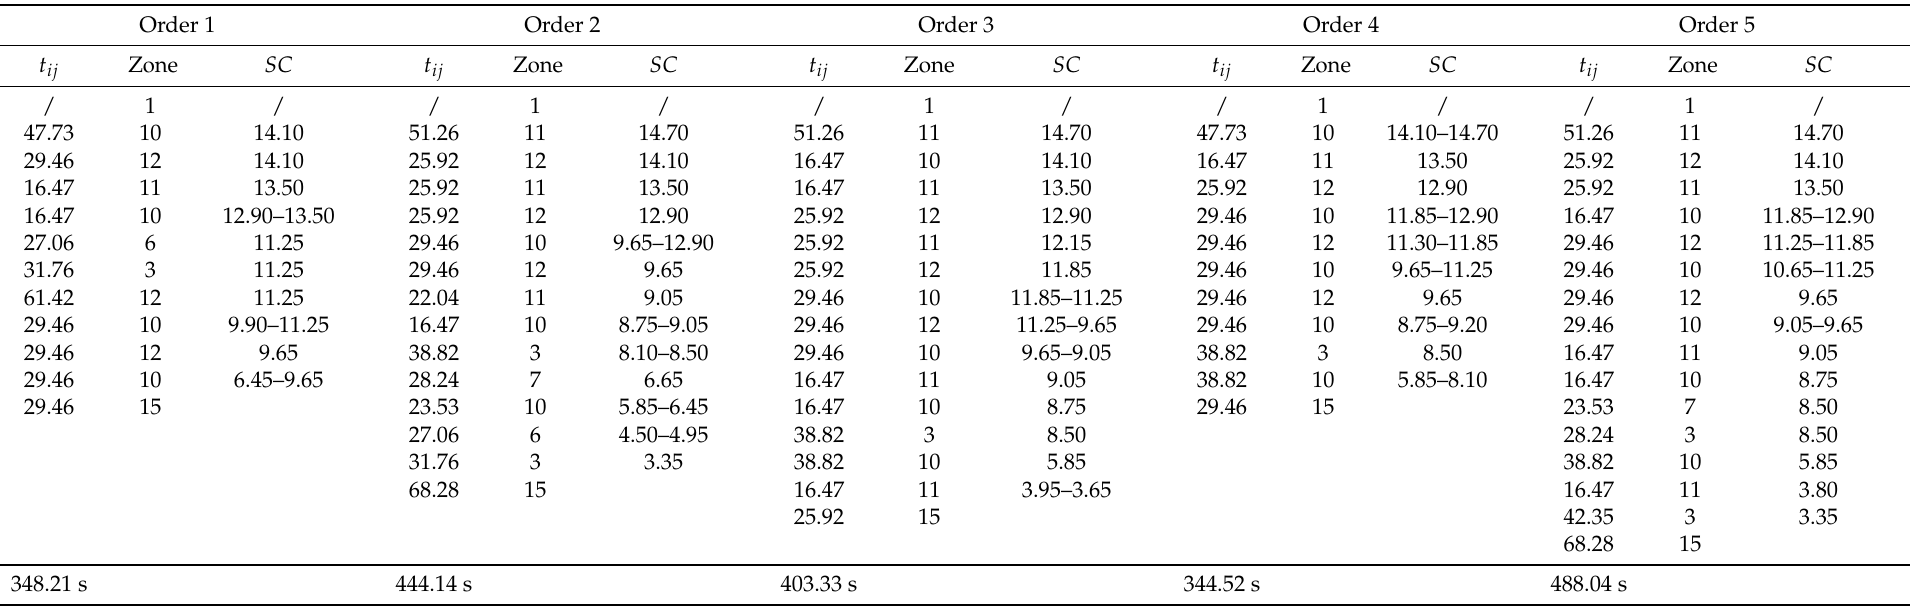
Table 4. Simulation of travel times for 10 BOPS orders when the SOP optimization is